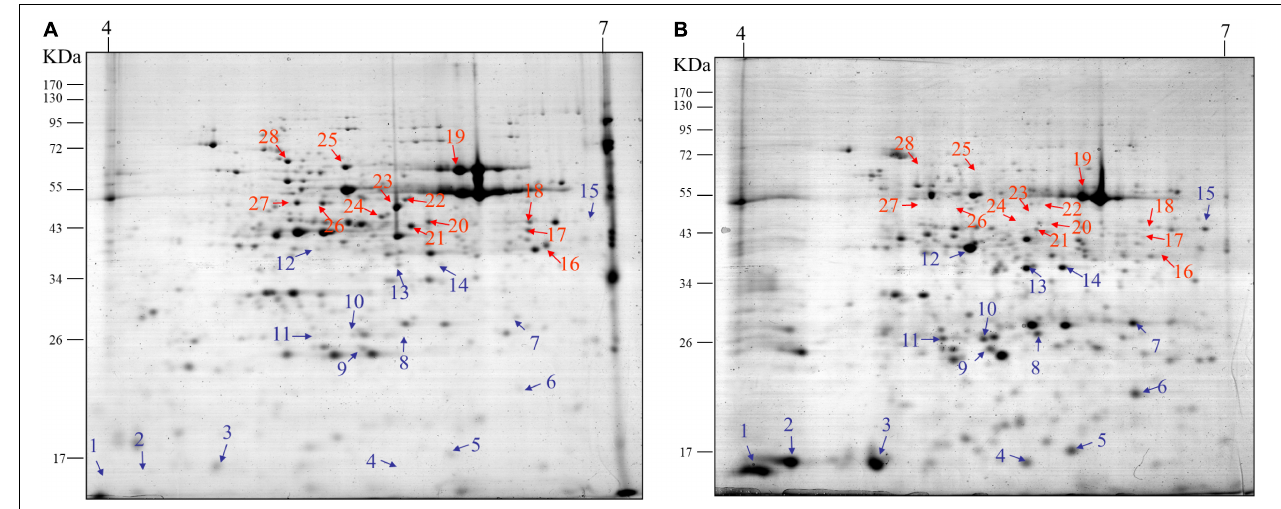
FIGURE 2 | Results of 2-DE analysis of proteins extracted from soybean leaves. Representative 2-DE gel image showing proteins extracted from soybean leaves at the V1 stage (A) and R7 stage (B) . At least 28 proteins showed significant differences between the two gels. Among these, 15 proteins showed a significantly high accumulation (blue arrows) whereas, 13 showed significant reduction (red arrows) at the R7 stage (B) compared to the V1 stage (A)